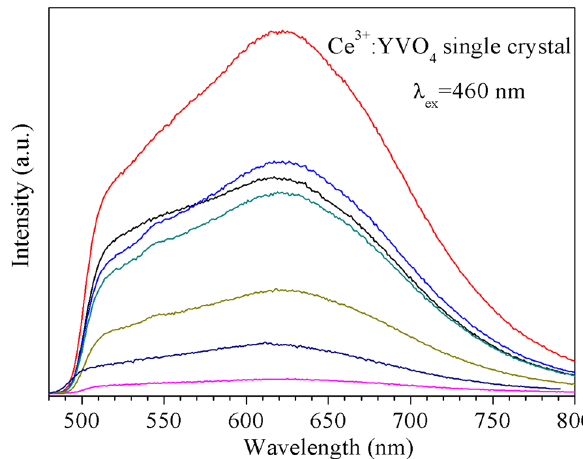
Table 1: Absorption and emission wavelength of Ce 3 + - doped